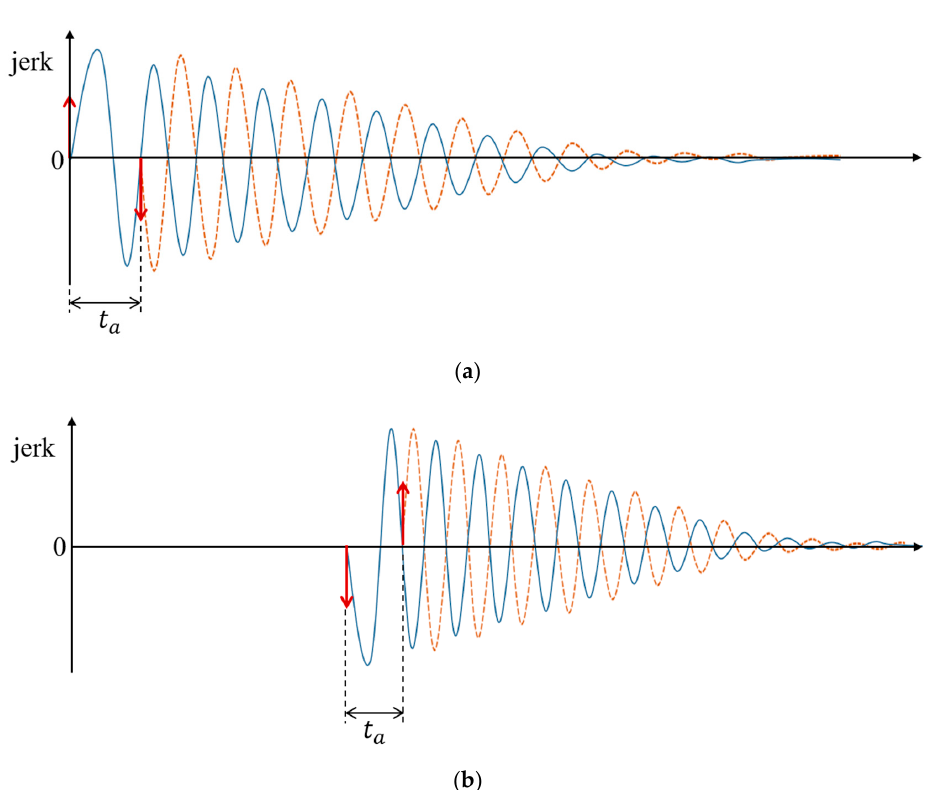
Figure 7. The case where the residual vibrations caused by two jerks are eliminated: ( a ) in acceleration phase; ( b ) in deceleration phase.